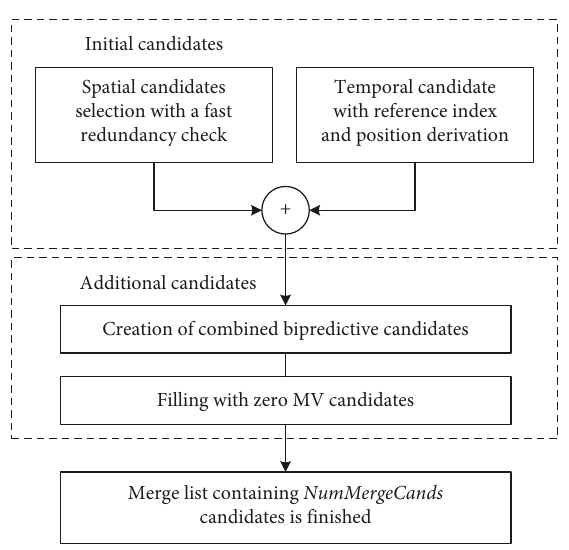
Figure 2: Construction of the merge candidate